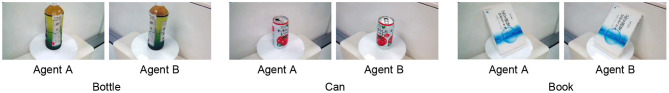
Examples of object's images: captured images of a bottle, can, and book from the viewpoints of agents A and B.